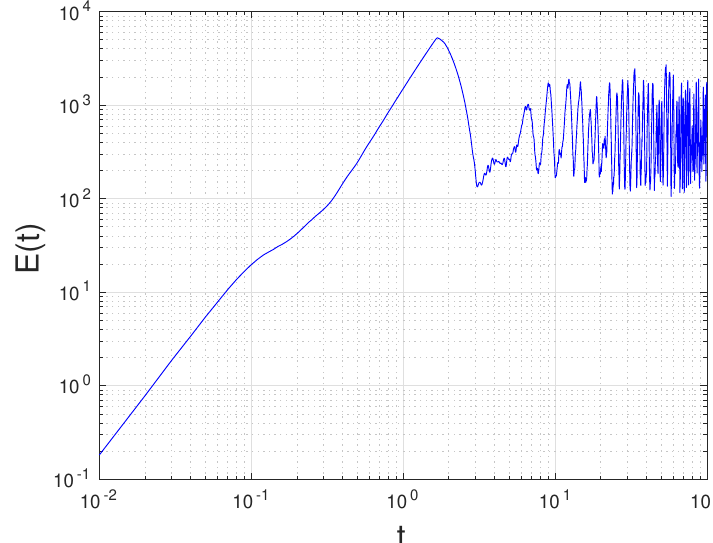
Figure 6. Time evolution of the kinetic energy of the FOM.